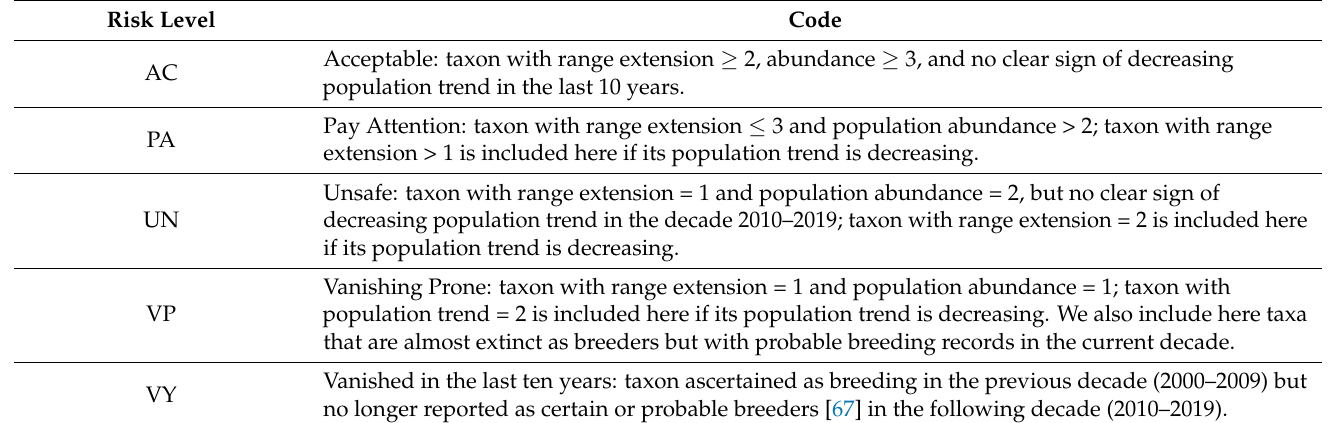
Table 4. Red List: risk levels expressed for each taxon belonging to the OCL (2010–2019) (see text for